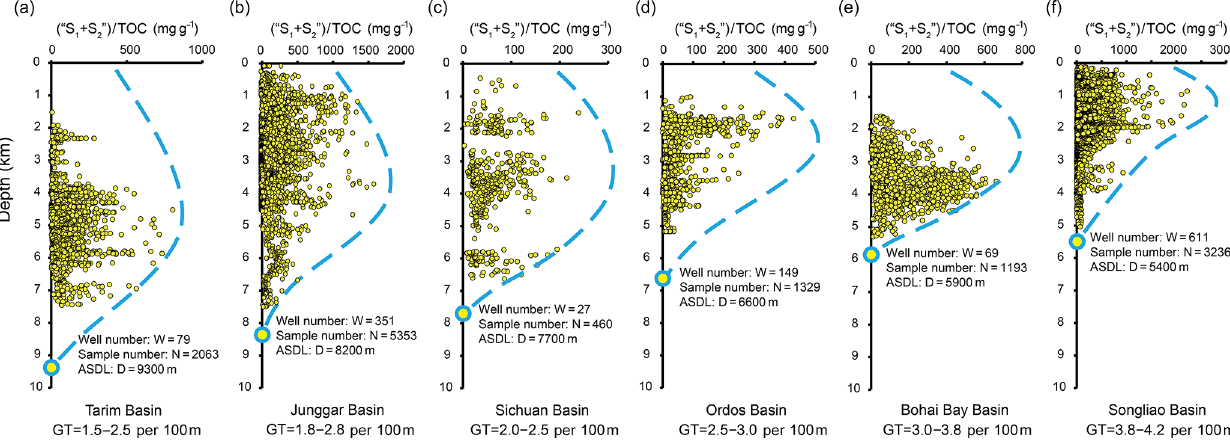
Figure 4. Variation in ASDLs in the six representative basins due to different heat flows. The ASDLs of different petroliferous basins are characterized by hydrocarbon generation potential index (represented by “ S 1 + S 2 ” / TOC). From left to right, the heat flow (geothermal gra- dients) of each basin gradually increases, while the corresponding ASDL becomes shallower. (a) Tarim Basin. (b) Junggar Basin. (c) Sichuan Basin. (d) Ordos Basin. (e) Bohai Bay Basin. (f) Songliao